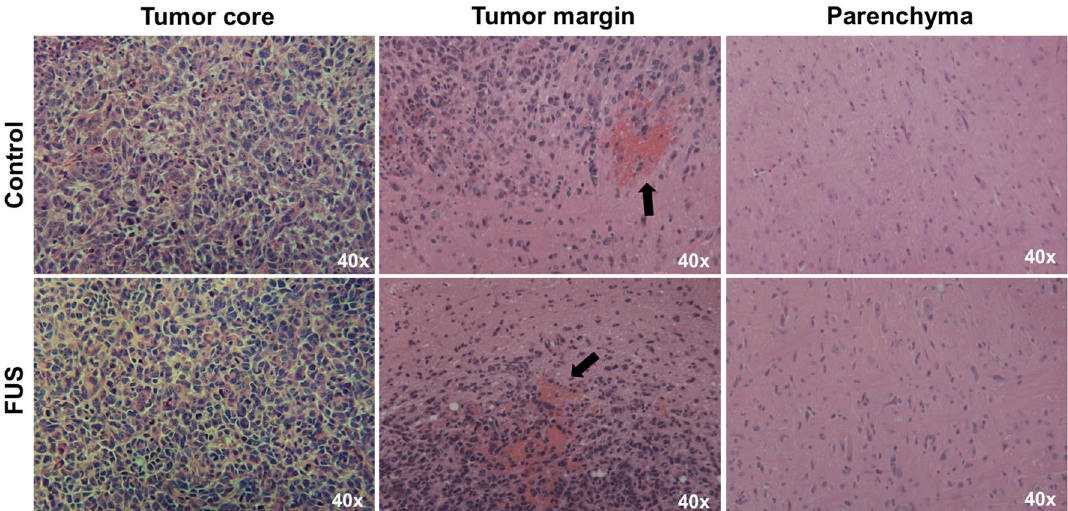
Figure 5. Representative photomicrographs of H&E-stained tissue from control and treated mice. Review of the histology by two blinded neuropathologists showed no difference. Tumor margins in both groups showed regions of microhemorrhage (black arrows) likely secondary to tumor invasion. No peri-tumoral parenchymal injury was